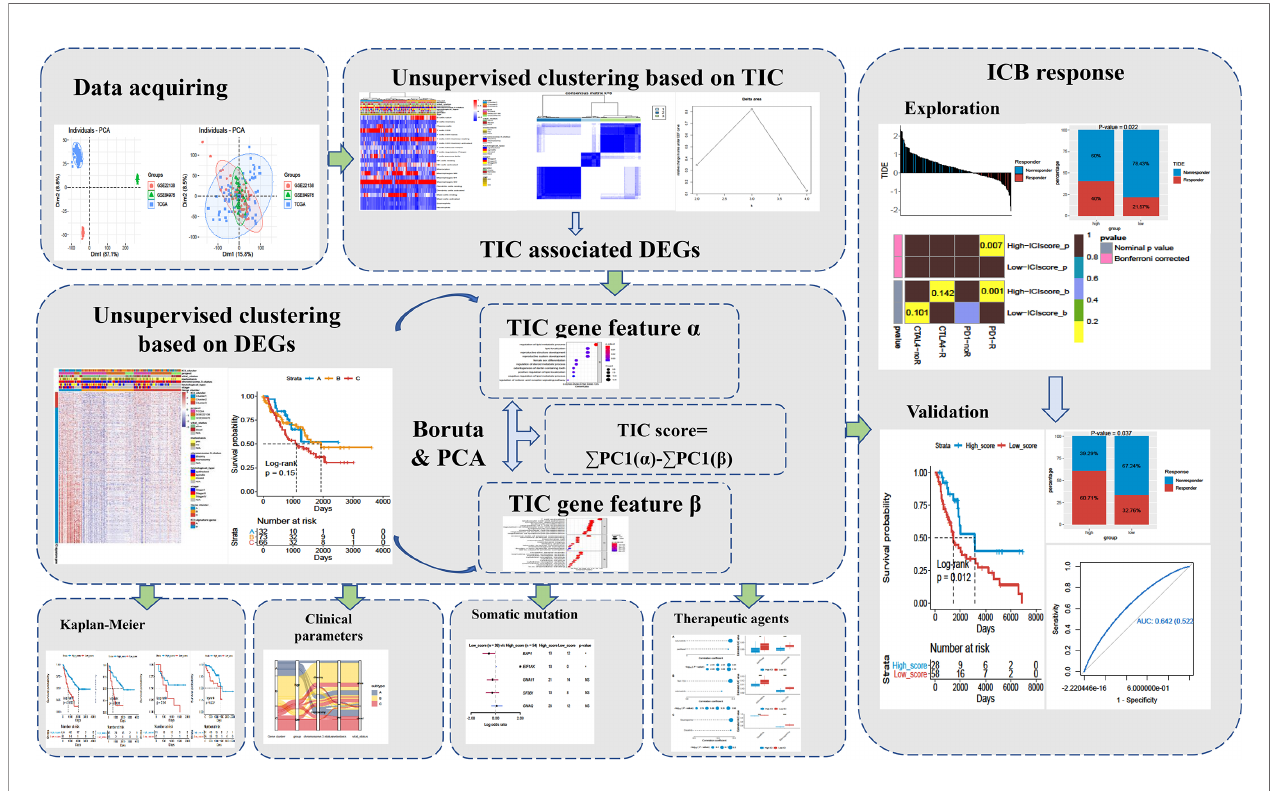
FIGURE 1 | The complete research work fl